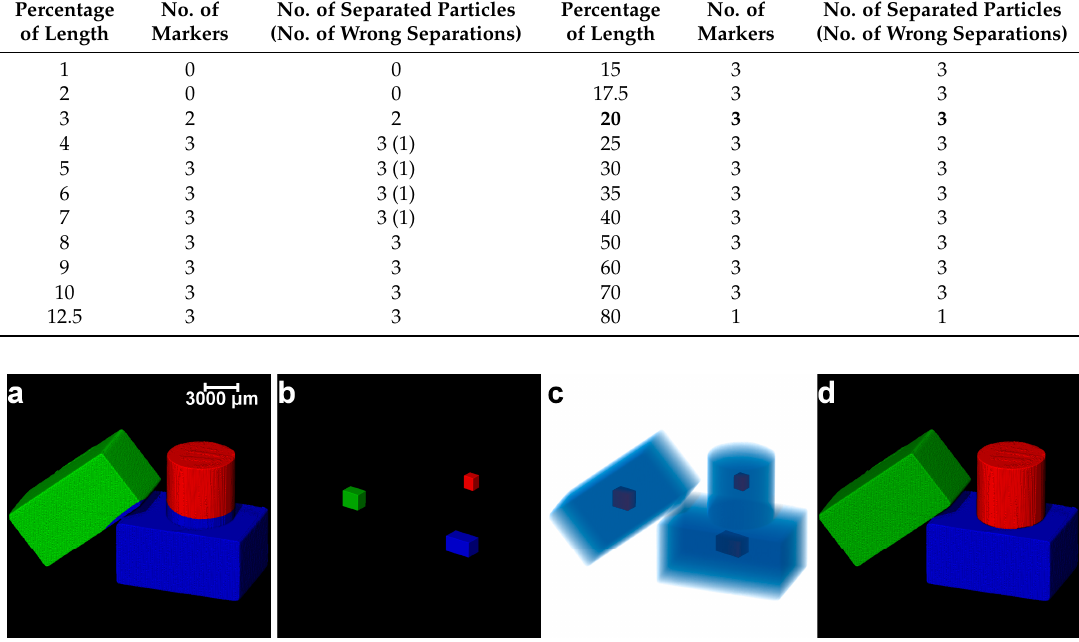
Figure 7. Separation of three blocks using the GMM clustering: ( a ) clusters; ( b ) extracted markers; ( c ) markers imposed on the blocks; and ( d ) separated blocks.